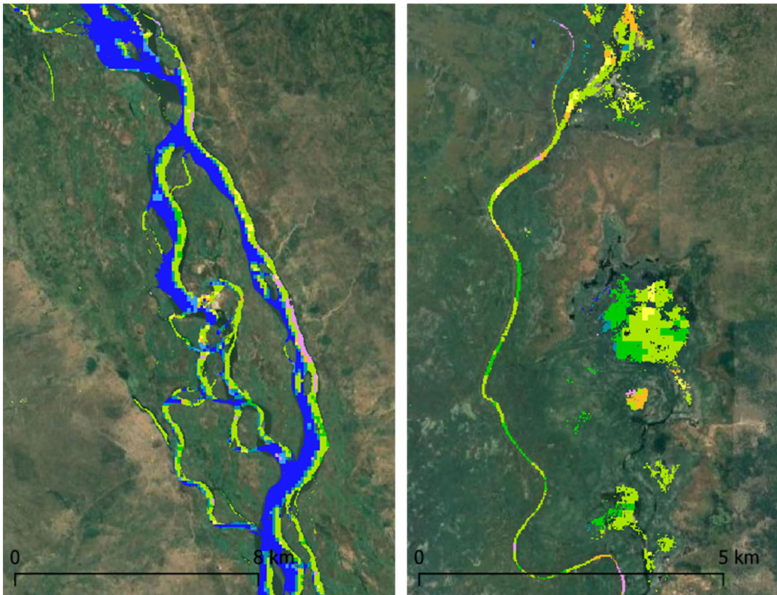
Figure 18. Left: Detail area ( f ) in Figure 10. Right: Detail area ( g ) in Figure 10. Pixels corresponding to cluster 9 are colored according to the underlying CORINE class; background from Google Earth TM imagery.